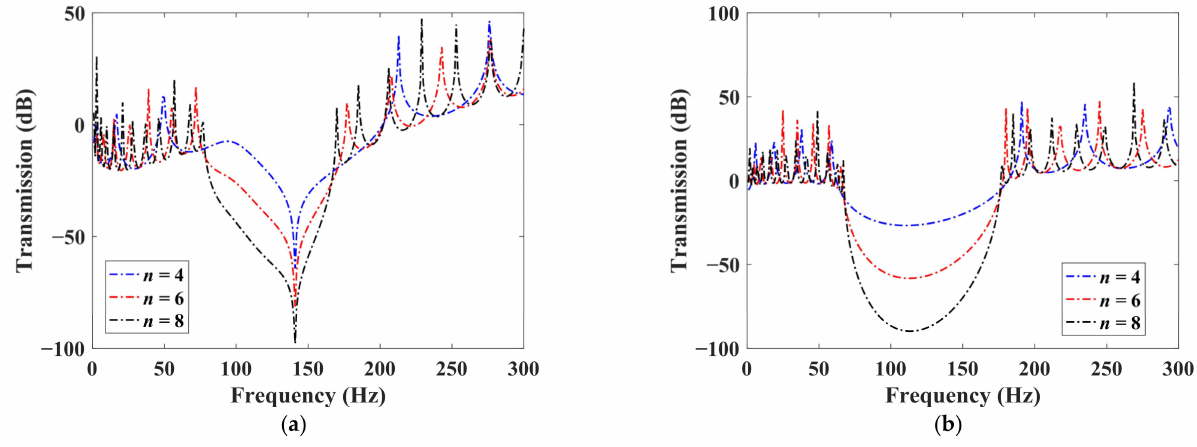
Figure 10. The transmission response curves with different period number n : ( a ) Euler beam; ( b ) Timoshenko